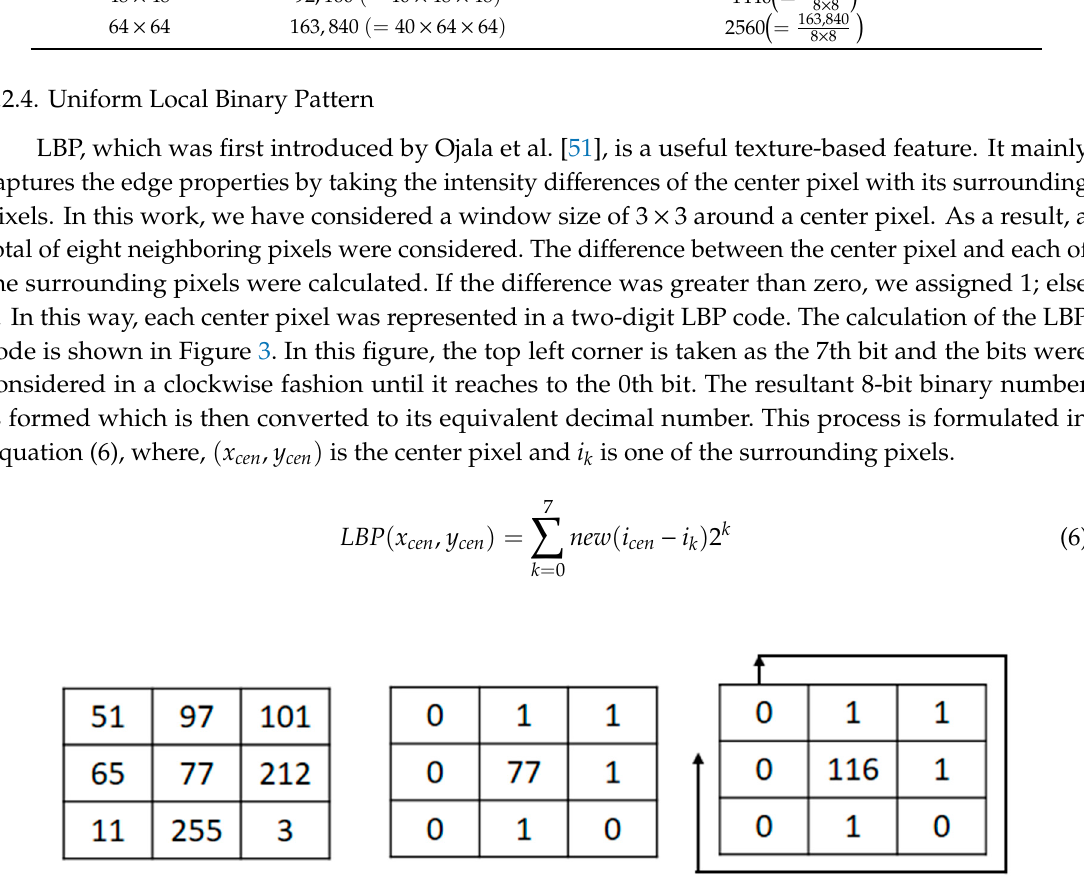
Figure 3. Clockwise direction gives (01110100) 2 = (116) 10 as the center pixel after local binary pattern (LBP)